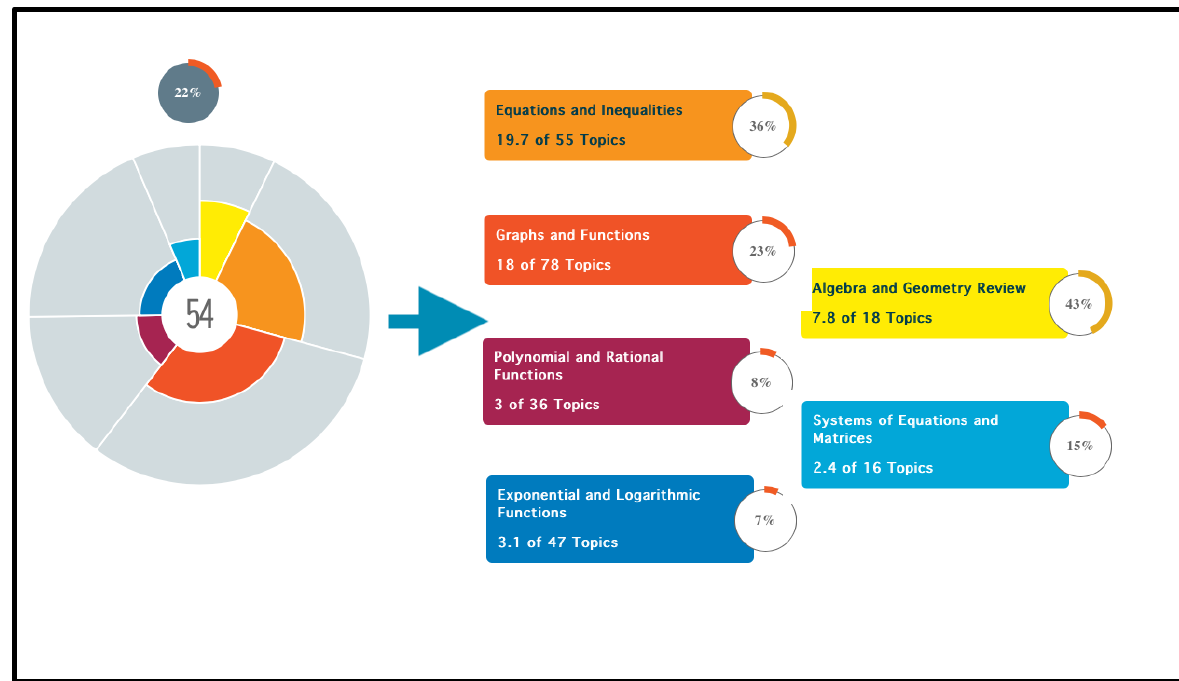
Figure 9b. The Pie report (ALEKS) illustrates students’ mastering information after the initial knowledge check. The instructor can build on this baseline in follow-up class meetings or online communications. Adapted from MAC1105C: College Algebra, by R. Ait Maalem Lahcen, 2019, Orlando, FL: University of Central Florida. Copyright 2019 by the University of Central